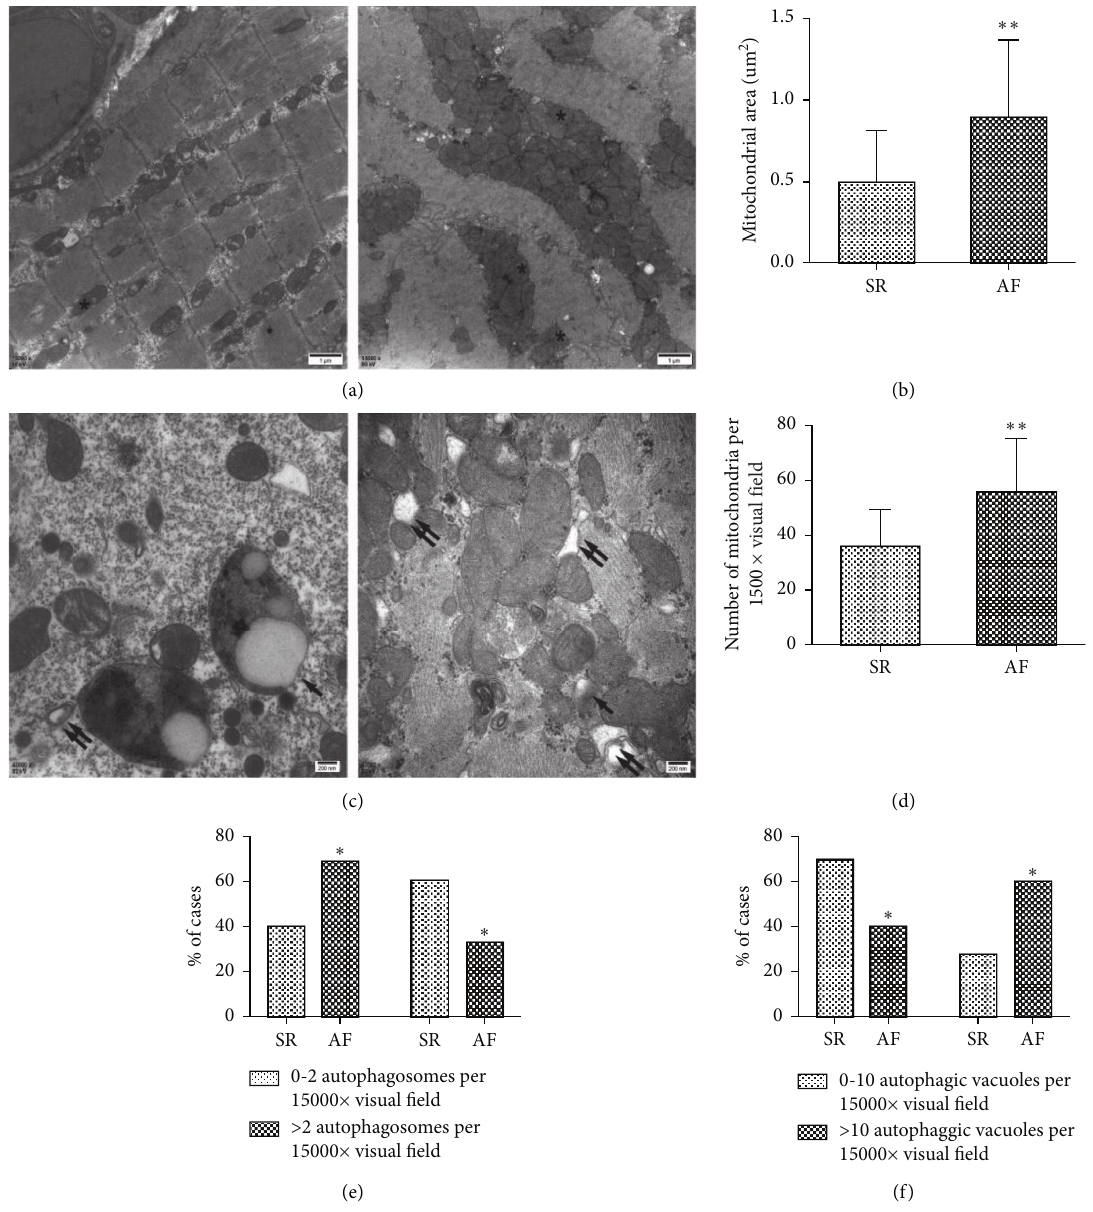
Figure 2: Mitochondria accumulation and increased autophagic vacuoles in atrial myocytes of patients with chronic AF. (a) Representative electron microscopic images of mitochondria in RAA ( n � 5 per group, scale bar � 1 μ m). The asterisk indicates typical mitochondrial. (b, d) Semiquantitative analysis of mitochondrial area and quantity of mitochondria in RAA. (c) Representative electron microscopic images of autophagosomes and autophagic vacuoles in RAA ( n � 5 per group, scale bar � 200nm). The autophagosome containing mitochondria is marked with a single arrow. The autophagic vacuole is marked with double arrows. (e, f) Semiquantitative analysis of autophagosomes and autophagic vacuoles in RAA. ∗ p < 0.05, ∗∗ p < 0.01 vs the SR group. SR, sinus rhythm; AF, atrial fibrillation; RAA, right atrial